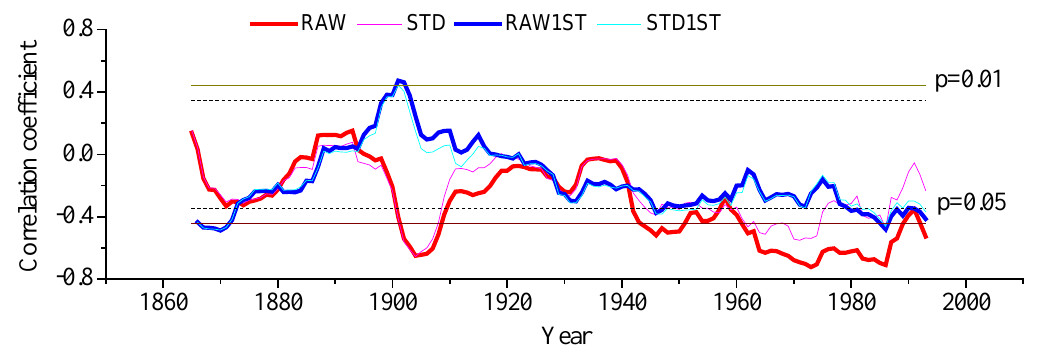
Figure 9. The 30-year sliding correlation between iWUE and the radial growth of trees. RAW represents the correlation coefficient between the iWUE and the original tree-ring width chronology; STD represents the correlation coefficient between the iWUE and the de-trended width chronology using the spline function method; RAW1ST represents the correlation coefficient between the first-order difference of the iWUE and the first-order difference of the original tree-ring width chronology; STD1ST represents the correlation coefficient between the first-order difference of the iWUE and the first-order difference of the de-trended width chronology.